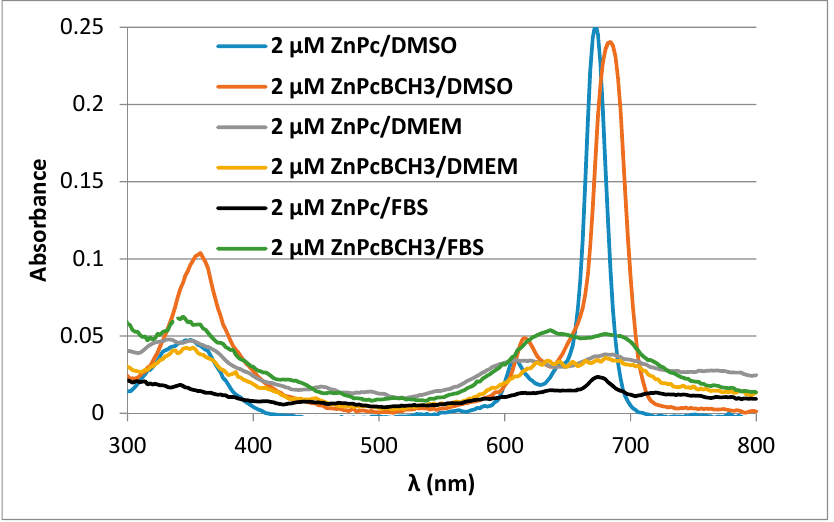
Figure 6. Monitoring the lipophilicity of ZnPc vs. ZnPcBCH 3 through the intensity of the visible spectra in DMSO, DMEM, and FBS media.